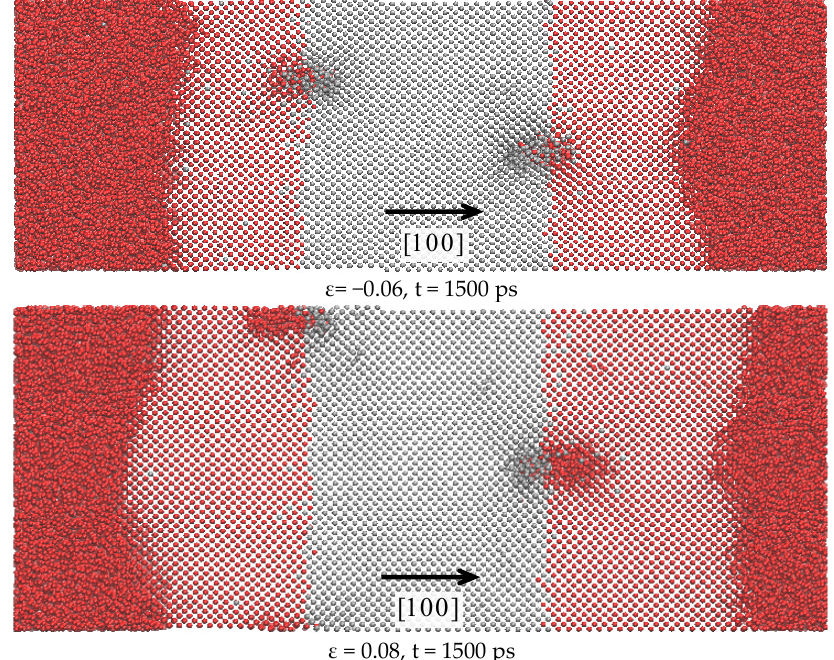
Figure 6. Snapshots of highly strained growths along <100>.